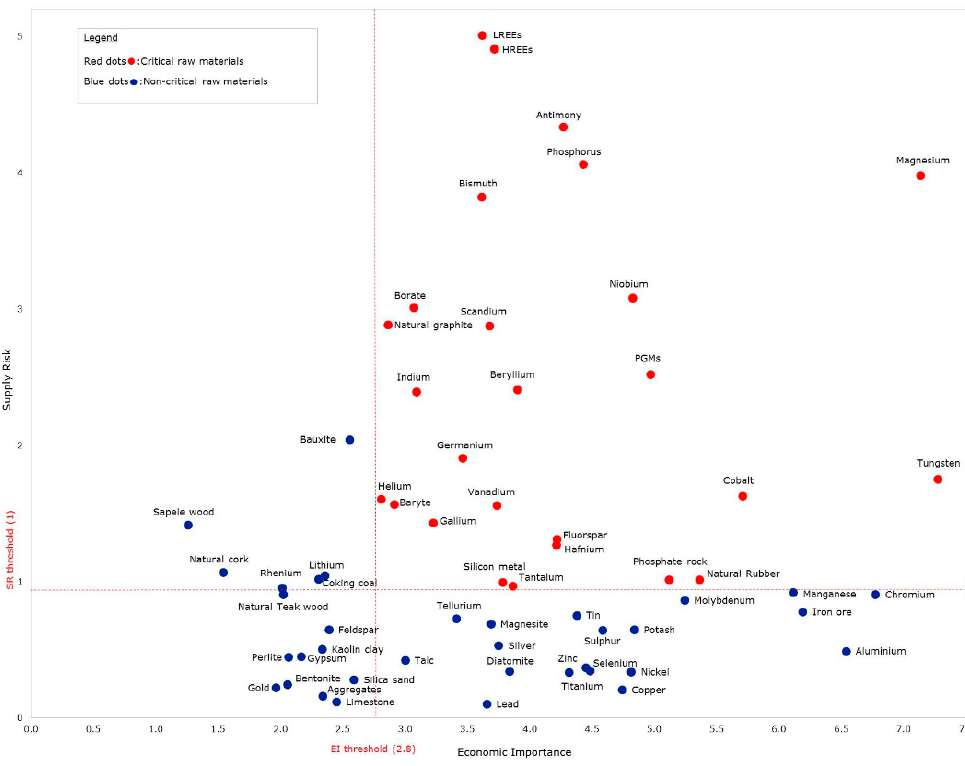
Figure 1. Economic importance and supply risk of raw materials in the European Union 2020 [7].